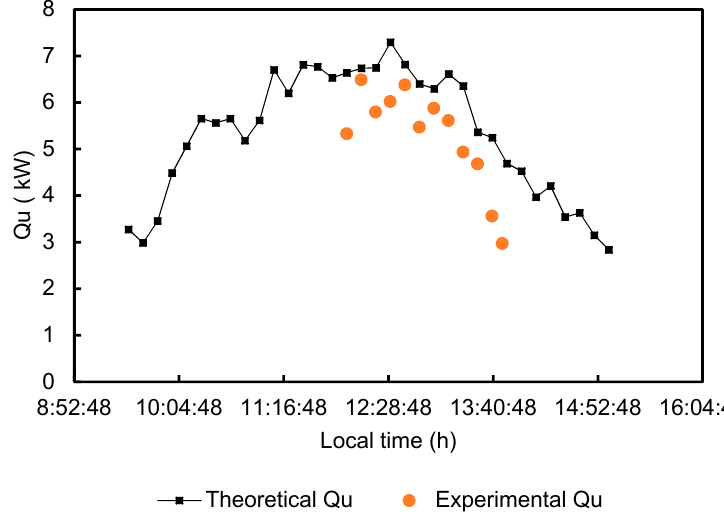
Figure 12. Theoretical and experimental useful heat in the solar collectors’ field.